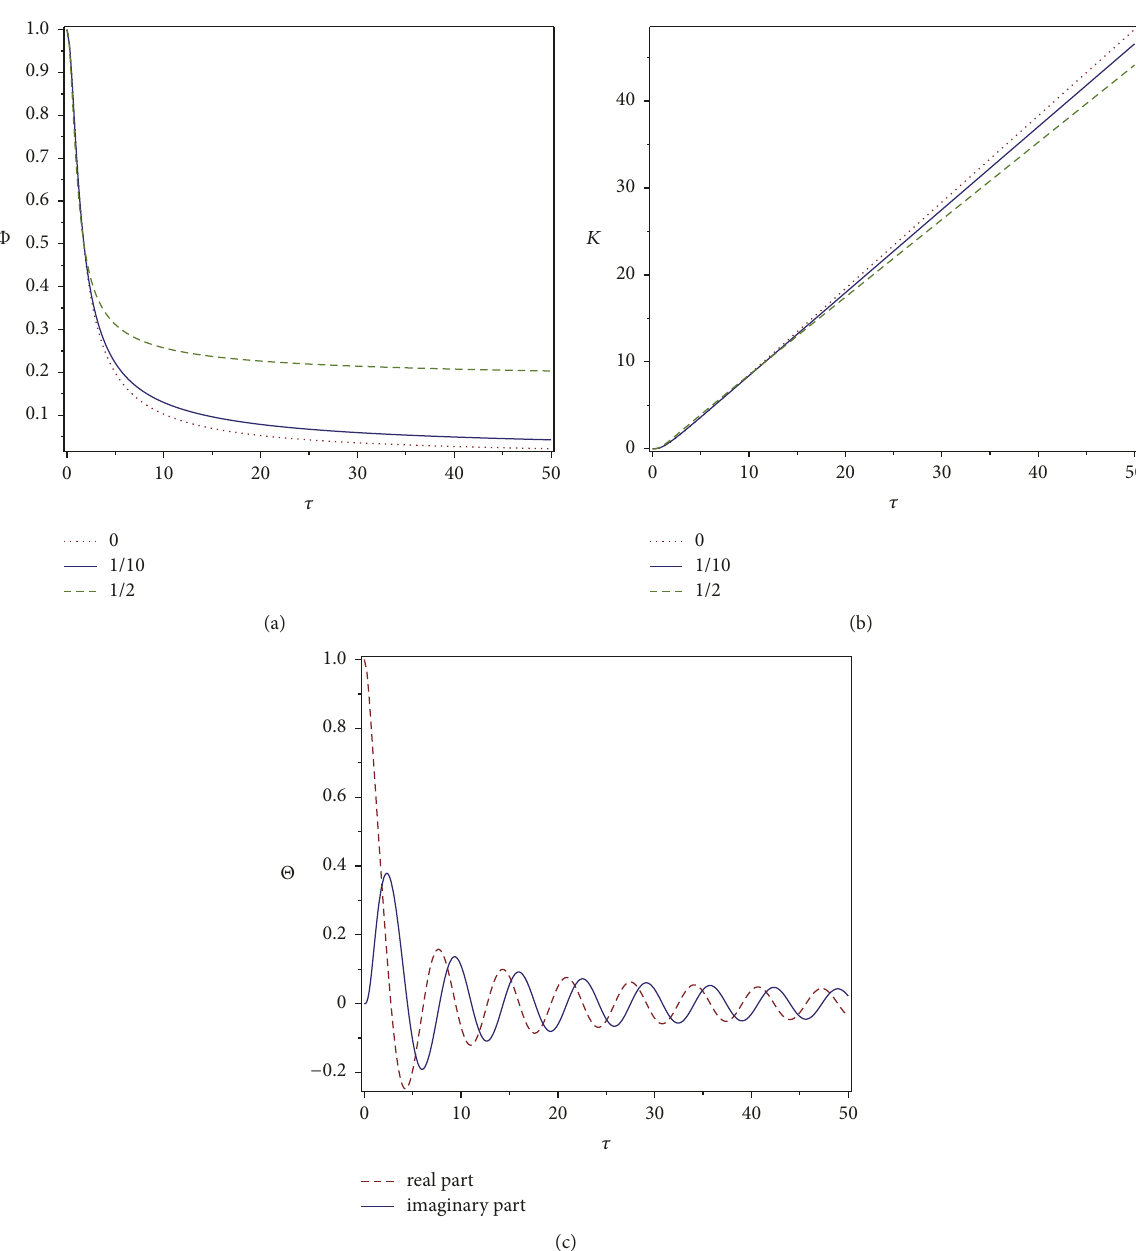
Figure 1: Plot of Φ = Φ + (𝑡) (a) and 𝐾 = 𝐾 + (𝑡) (b) in (29) in the presence of symmetric pure dephasing with ℎ(𝜔) = 𝜔 and for different values of 𝜇 = 0,1/10, 1/2 and in (c) the real and imaginary part of 𝑄 = 𝑄 + for 𝜇 = 1/10 . The amplitudes 𝜆 ± = 1 and time 𝜏 is in units 100/𝜔 푐